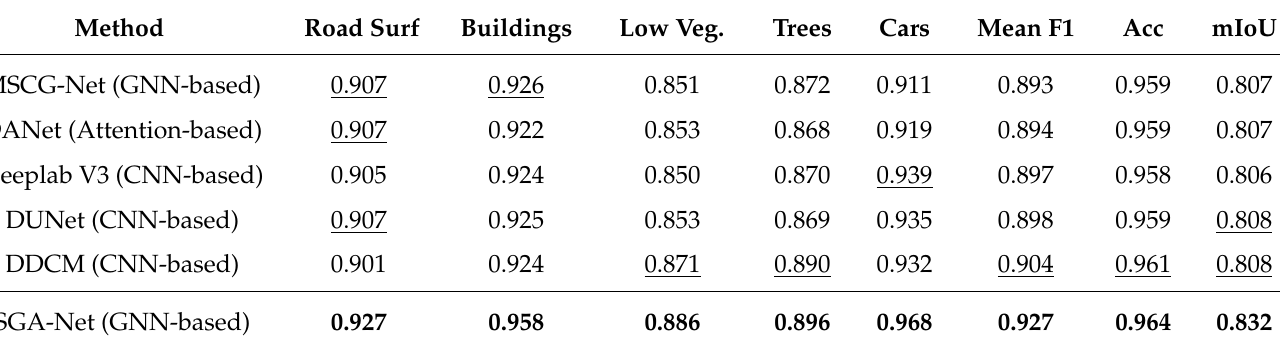
Table 1. The experimental results on the Potsdam dataset (bold: best; underline: runner-up). Method Road Surf Buildings Low Veg.